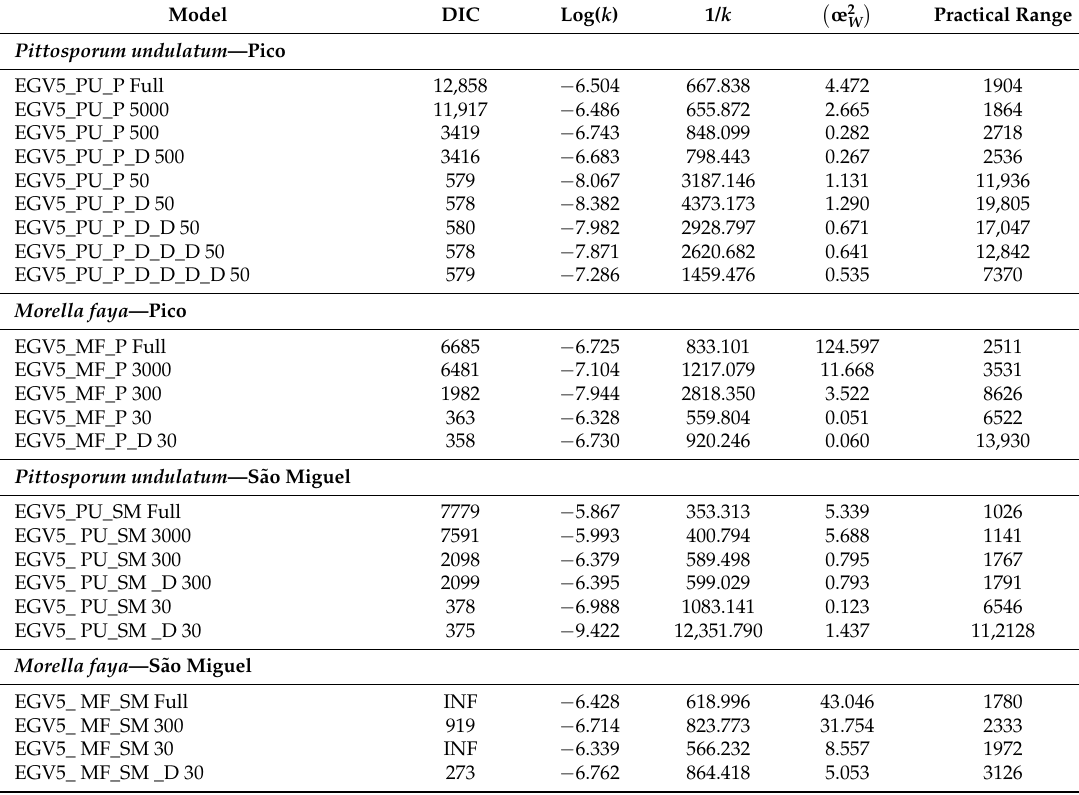
Table 9. Numerical summary of the posterior distributions of the best mixed effects models and their reduction for the two species studied in Pico and S ã o Miguel islands. This summary contains the DIC, the posterior marginal distribution of log ( k ) and 1/ k , the posterior marginal distribution of nominal variance of random field ( σ 2 ) and posterior marginal distribution of the practical range (meters). PU: W P. undulatum ; MF: M. faya ; P: Pico; SM: S ã o Miguel. Variables with non-significant values were excluded from the model (code: D) (Supplementary